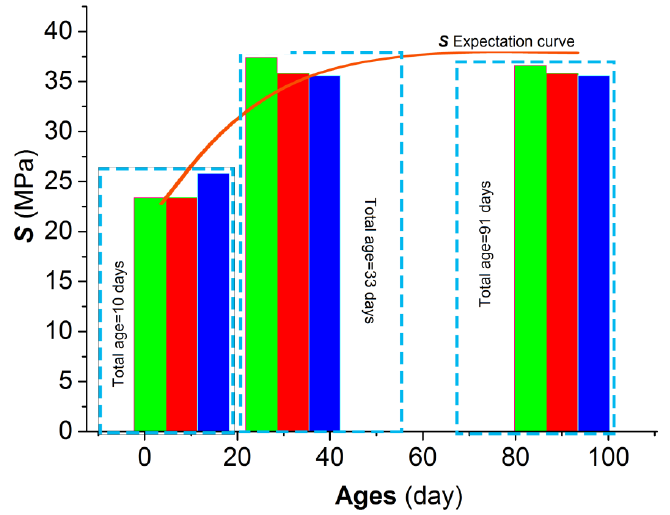
Figure 8. S distribution from UCTs.